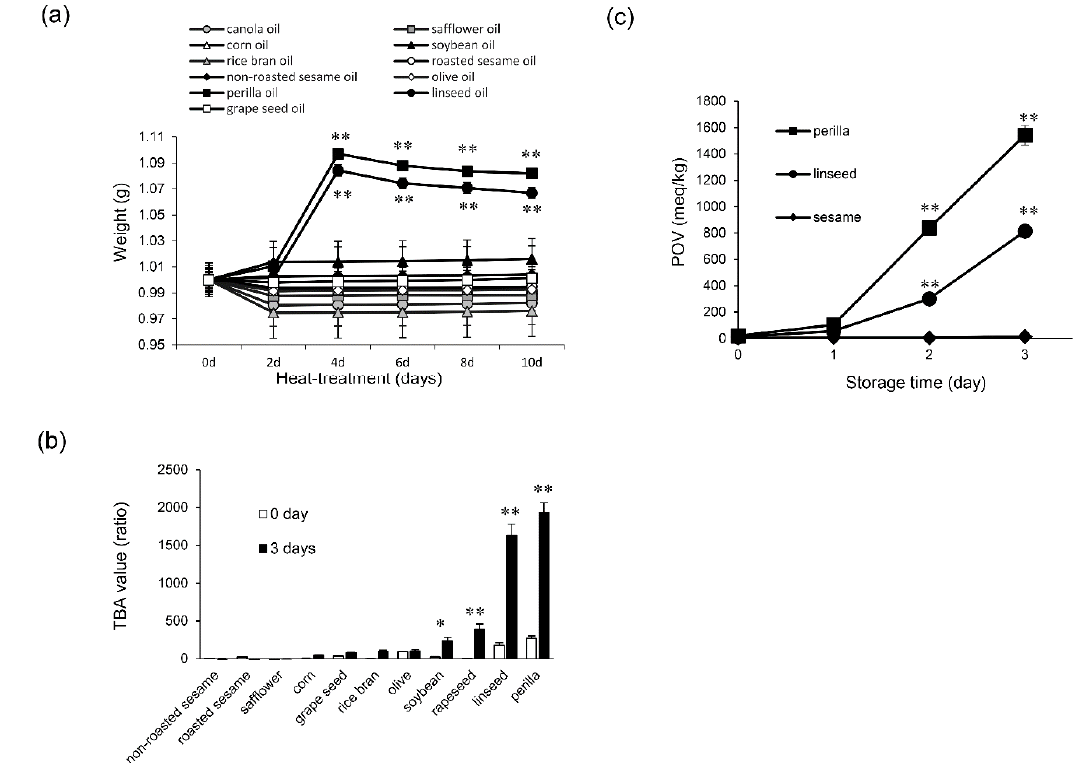
Figure 1. Oxidation state of edible plant oils. ( a ) Non-oxidized oil (0 d) and oxidized oil (2, 4, 6, 8 and 10 d) were evaluated for oxidation state by a gravimetric method. One-way ANOVA with Dunnett’s test was used. ** p < 0.01 and ## p < 0.01 compared with perilla oil (0 d) and linseed oil (0 d), respectively. ( b ) Non-oxidized oil (0 d) and oxidized oil (3 d) were evaluated for oxidation state by the TBA method. Student’s t test was used. * p < 0.05 and ** p < 0.01 compared with control (0 d). ( c ) Peroxide value (POV) of perilla, linseed, and non-roasted sesame oils during the conservation period (in days) at 60 ◦ C. Results are expressed as mean ± SD (n = 3). One-way ANOVA with Dunnett’s test was used. ** p < 0.01 compared with control (0